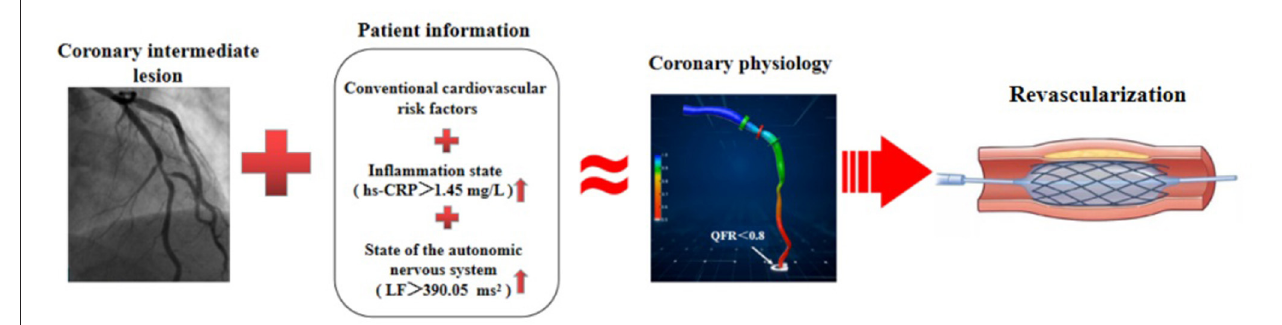
FIGURE 7 | Schematic diagram for evidence to diagnose functional ischemia. In the absence of QFR analysis, model-based risk assessment including LF, hs-CRP, GS, and traditional risk factors, can predict functional ischemia in patients with coronary intermediate lesions and inform whether or not to schedule